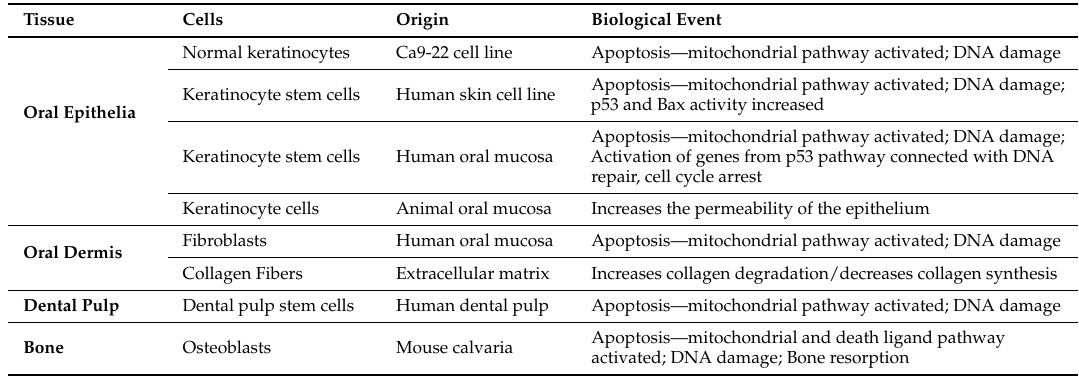
Table 2. Biological effects of high physiological concentrations of H 2 S on different oral cell types (50 ng/mL H 2